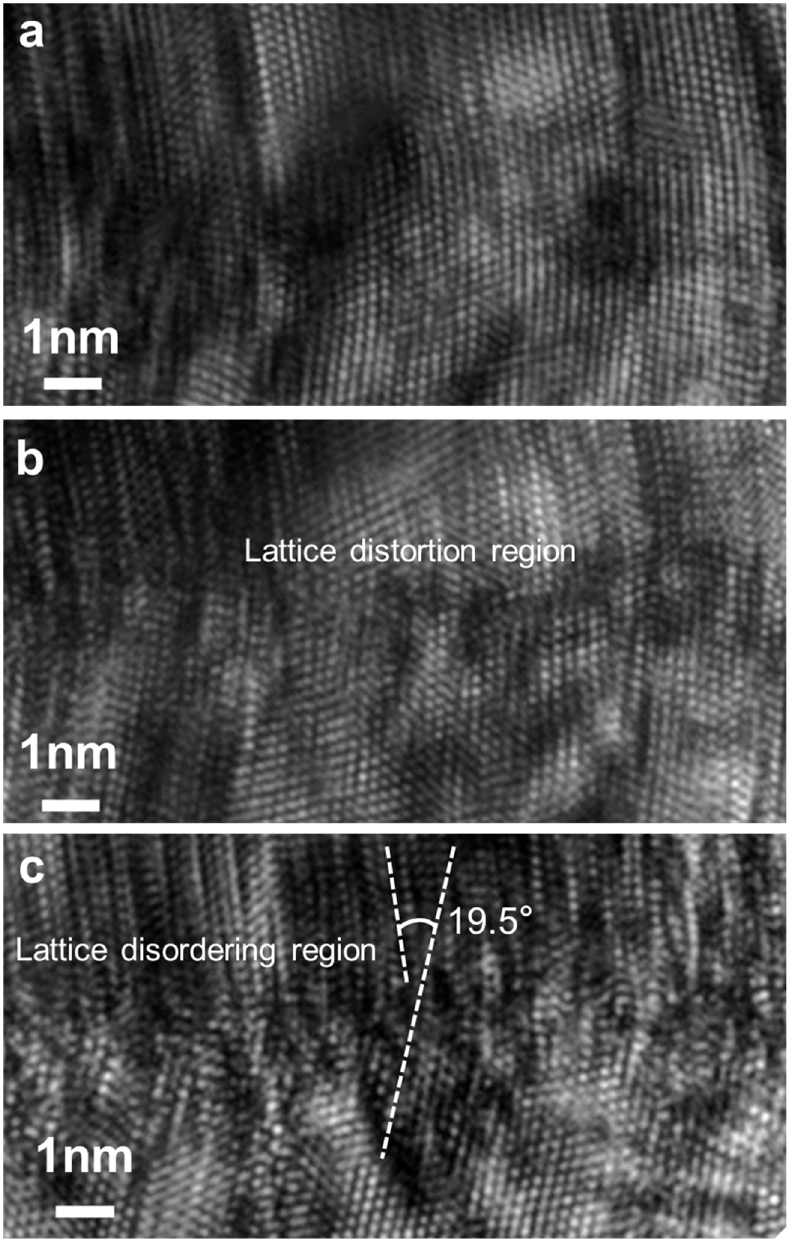
Figure 6. ( a ) HTEM image showing the {111} lattices are arc-shaped under bending. ( b ) the lattices became disordered under large bent strain. ( c ) Direct observation of the bending deformation leading to the generation of a tilted GB.